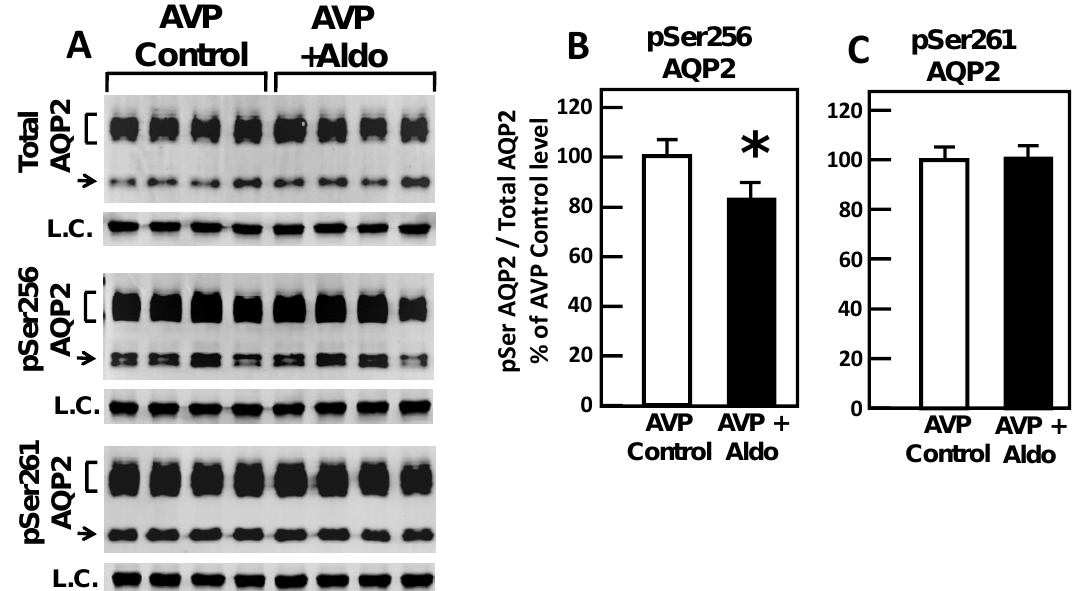
Figure 2. Aldosterone decreased phosphorylation of aquaporin-2 (AQP2) at serine 256 but did not change phosphorylation at serine 261 in male rat inner medulla (IM). ( A ) Representative western blots showing total AQP2 and phosphorylated AQP2 abundances in rat IM with AVP control vs. AVP plus Aldo for 30 min. Brackets indicate the glycosylated AQP2 protein between 35 and 45 kDa and arrow indicates the un-glycosylated AQP2 protein at 29 kDa. Beneath each AQP2 blot is the tubulin loading control blot (L.C.). Samples are from four di ff erent rats. The two kidney inner medullas from the same animal were randomly assigned into the AVP control or the AVP-Aldo groups. The matched pairs comparisons were achieved by comparing Lane 1 with Lane 5, Lane 2 with Lane 6, Lane 3 with Lane 7, and Lane 4 with Lane 8. ( B ) and ( C ) bar graph showing the ratio of pSer256 ( B ) or pSer261 ( C ) phosphorylated AQP2 to total AQP2 abundance as the percentage of the AVP-only control. Bars = means ± SE; * P < 0.05 AVP control vs. AVP with Aldo; N = 4 rats /